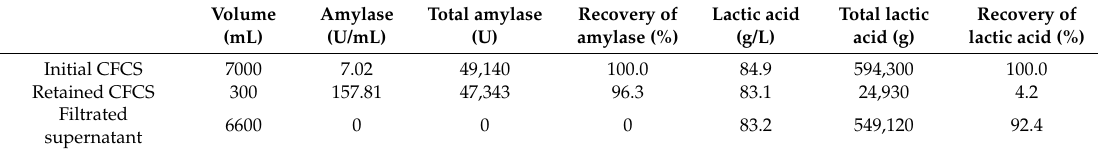
Table 5. Amylase and lactic acid recovery in an ultrafiltration system with 50 kDa MWCO.